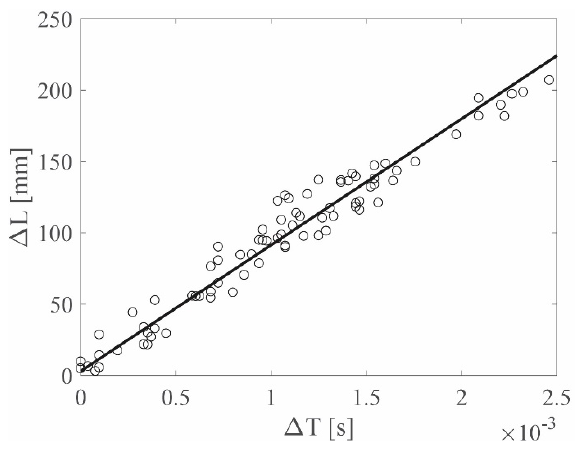
Figure 7. ( Δ L – Δ T ) graph example. Figure 7. ( ∆ L – ∆ T ) graph